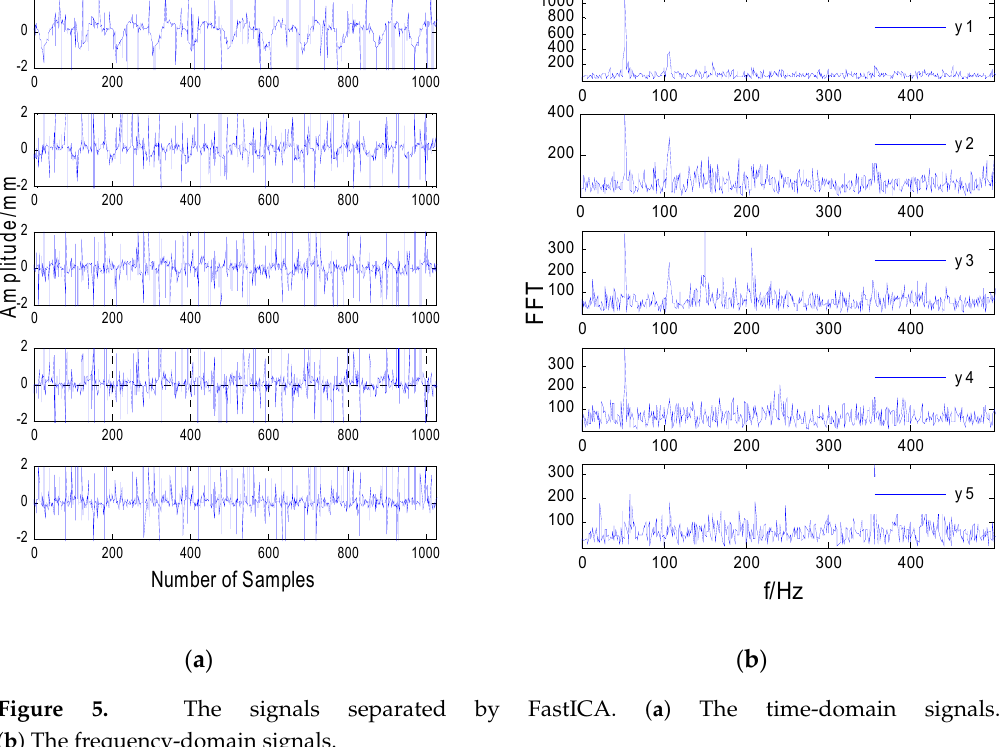
Figure 5. The signals separated by FastICA. ( a ) The time-domain signals. ( b ) The frequency-domain signals.